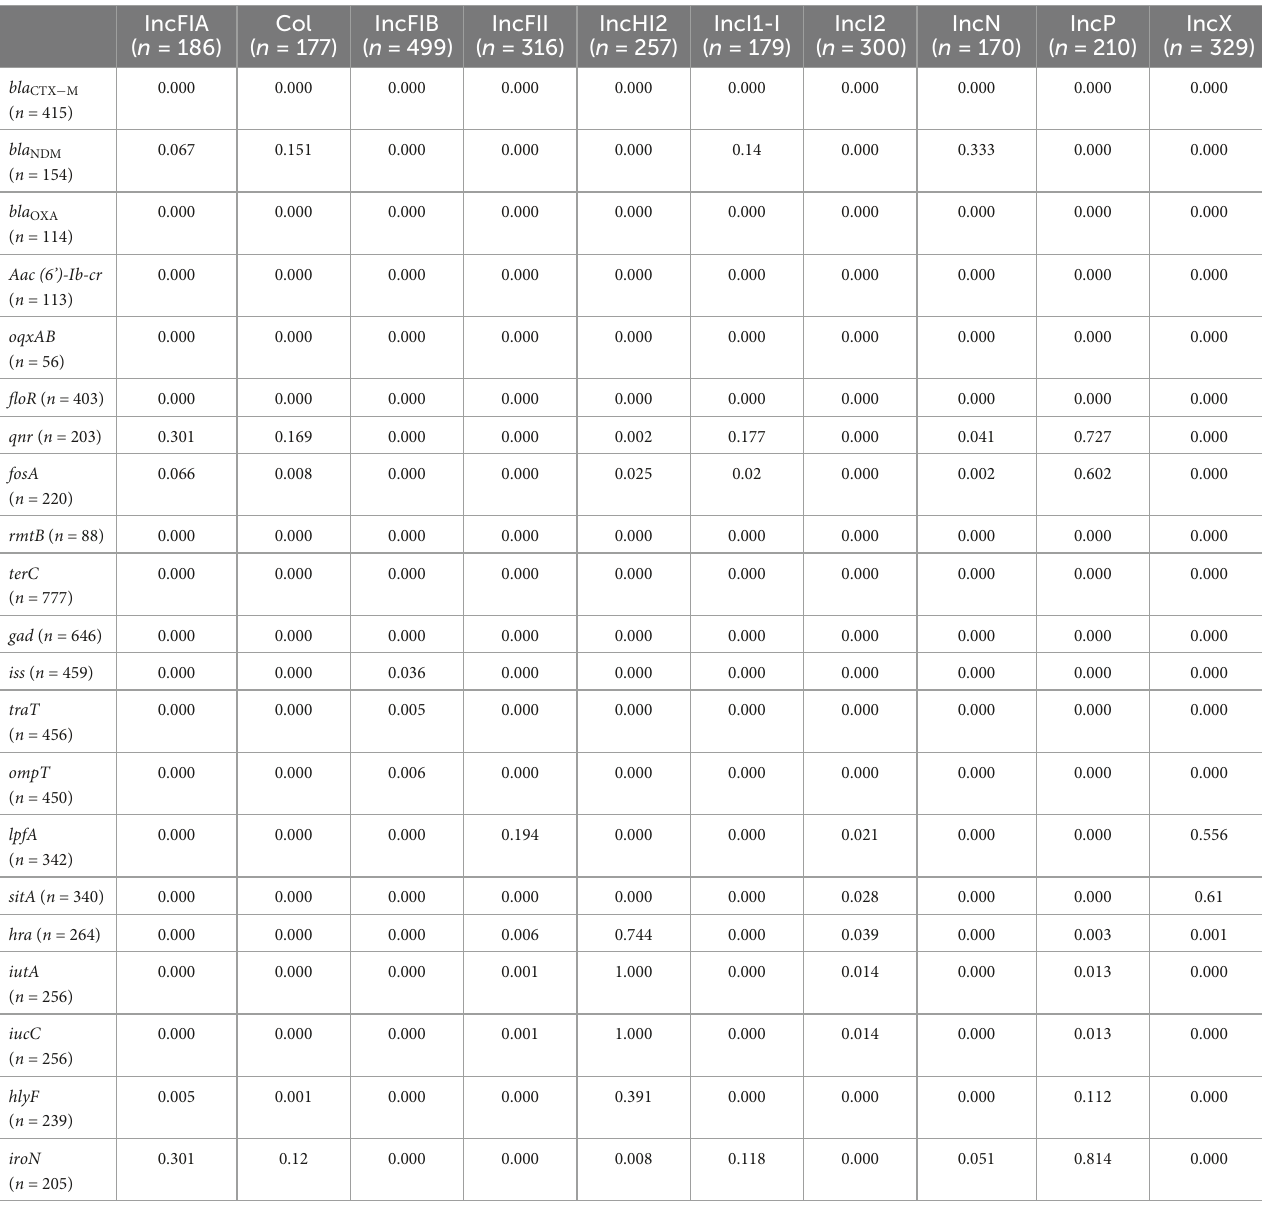
TABLE 3 P -values for differences in distribution of plasmid replicons and resistant/virulent